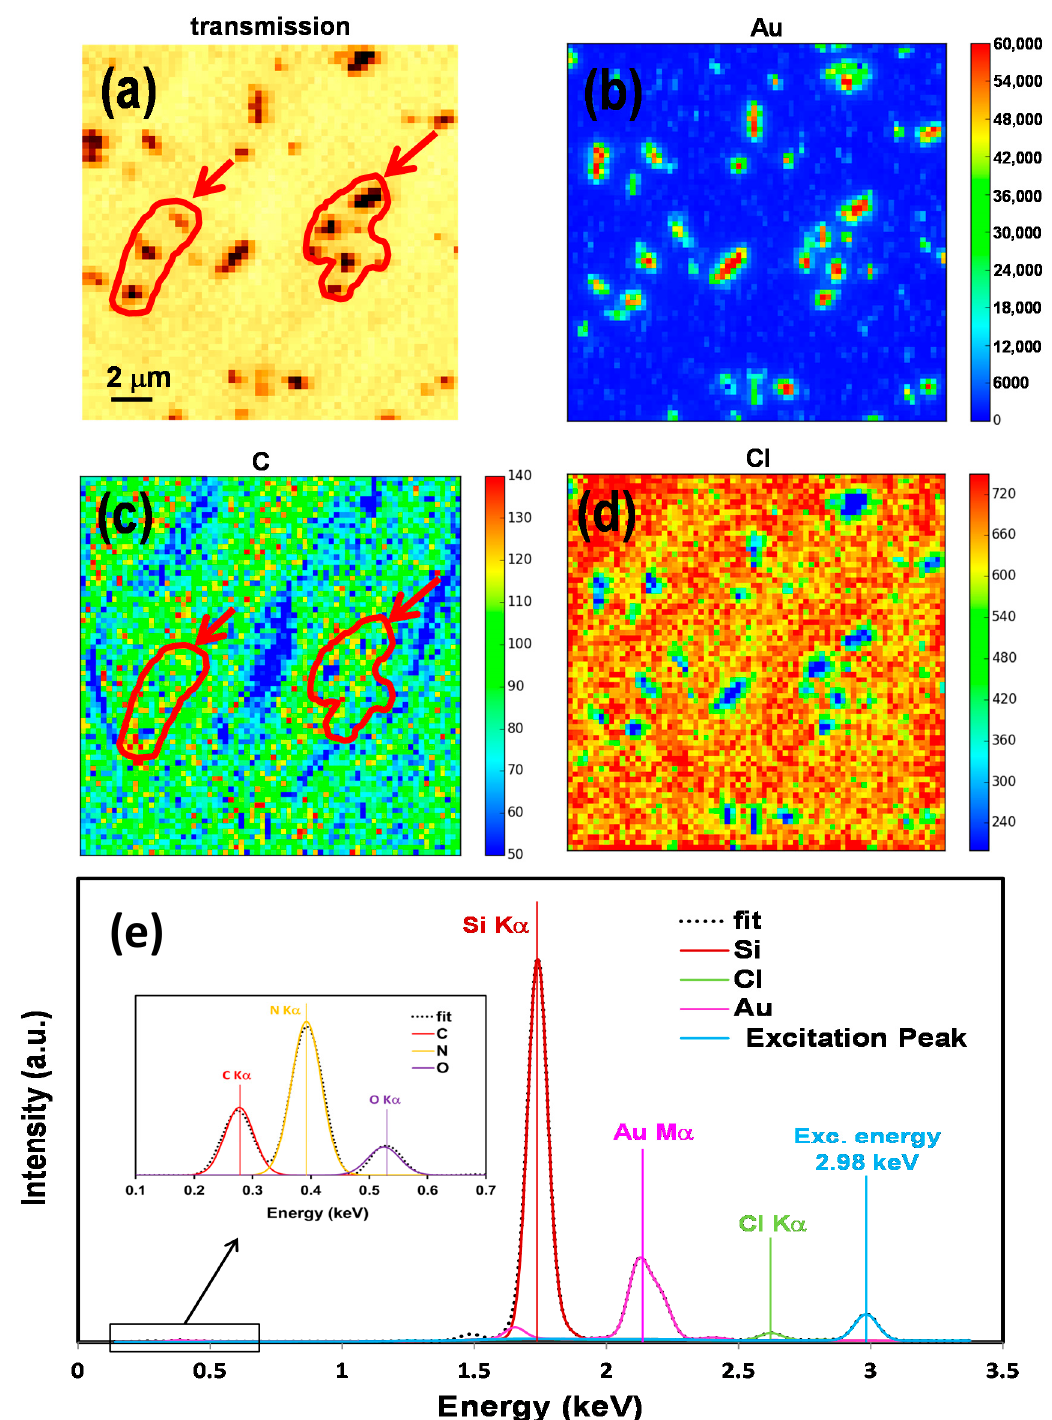
Figure 2. SXM image and XRF maps for P1-20-GNRs. ( a ) Transmission image taken at 2.98 keV; ( b ) XRF map for Au M α ; ( c ) XRF map for C K α ; ( d ) XRF map for Cl K α ; and ( e ) typical X-ray fluorescence spectrum from SDD detector fitted and processed using PyMCA software. Inset shows magnified region of low energy part of XRF spectrum including C K α , N K α , and O K α signals. N K α and Si K α signals are from Si 3 N 4 substrate. The two red contours, pointed out by arrows in carbon map ( c) are drawn for clarification and showing the equivalent location of two chosen GNRs patches in image ( a